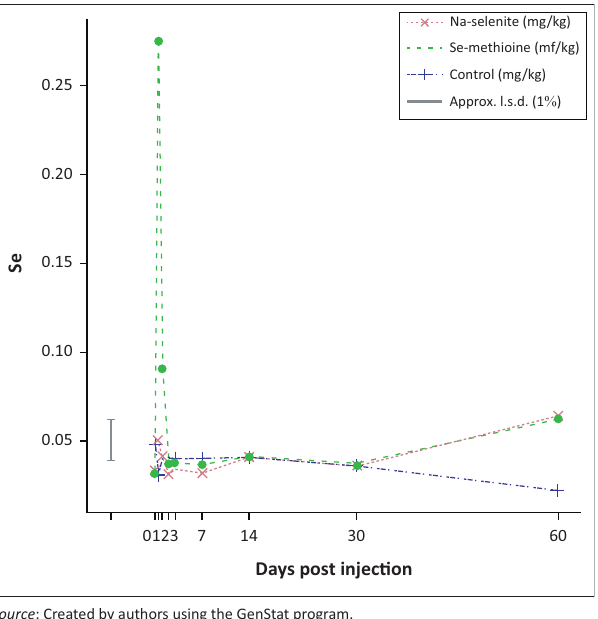
FIGURE 3: Serum selenium means per day (mg/kg) for different treatment groups. FIGURE 2: Milk selenium means per day (mg/kg) for different treatment